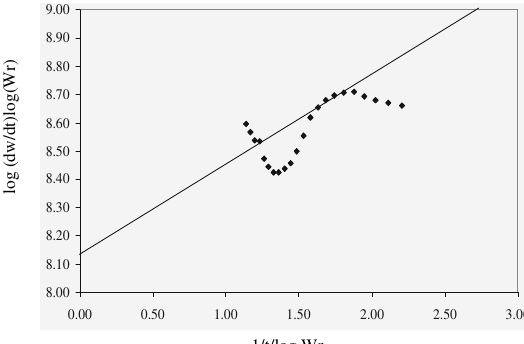
Figure 6. Freeman Carroll plot of terpolymer resin